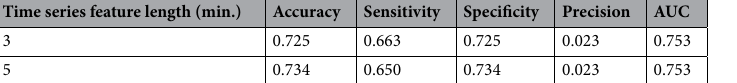
Time series feature length